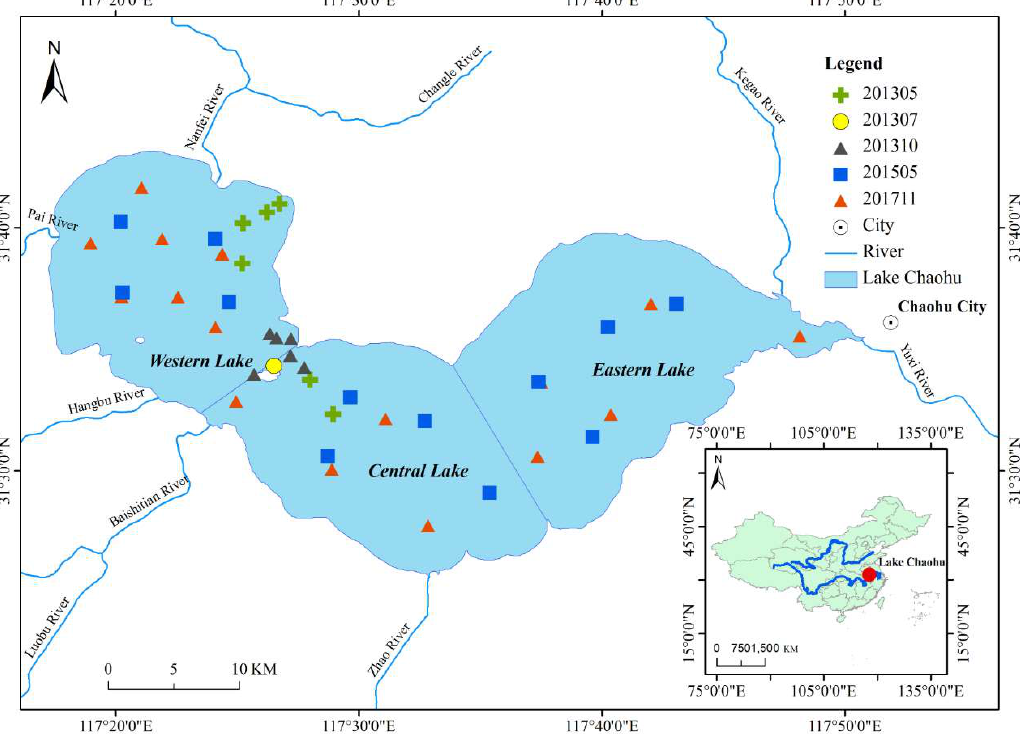
Figure 1. Lake Chaohu, China and the Western, Central and Eastern parts. In situ measurements were conducted in five surveys on 28 May 2013 ( N = 6), 24 July 2013 ( N = 2), 10–12 October 2013 ( N = 25), 25 May 2015 ( N = 12) and 27 November 2017 ( N = 9). The blue lines in the small frame show the Yangtze and Huang river.